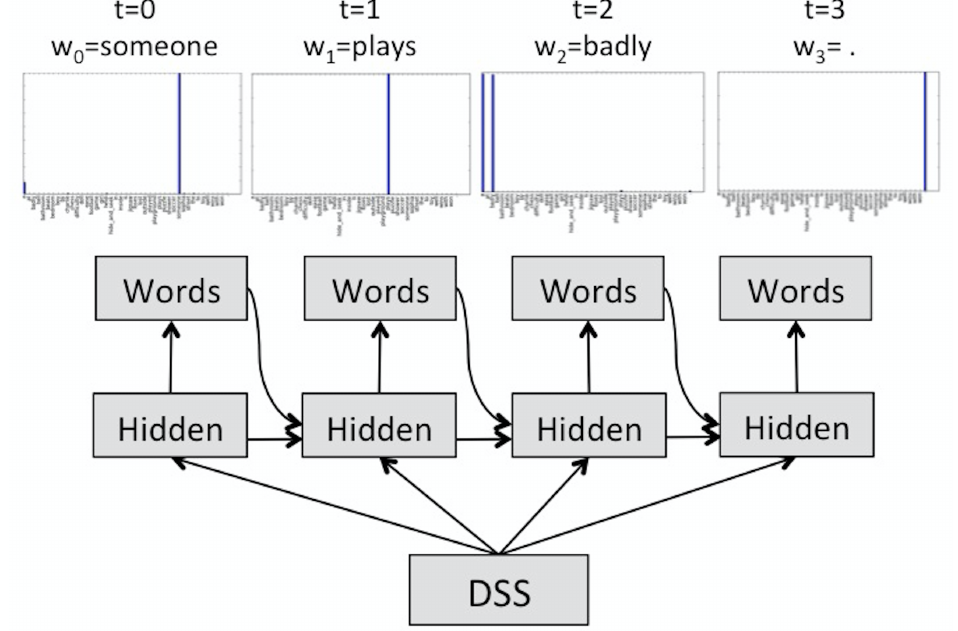
Figure 2. Example of sentence production: “someone plays badly